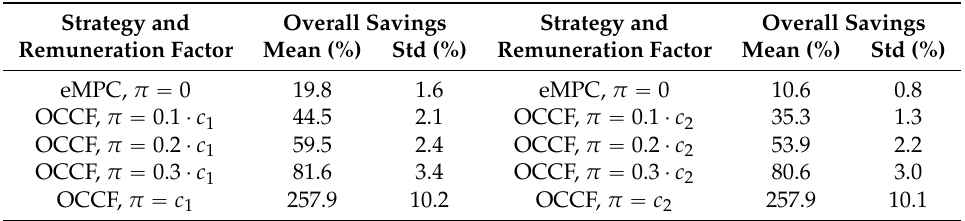
Table 7. Mean value and standard deviation of the overall savings with respect to the MT strategy. Strategy and Overall Savings Strategy and Overall Savings Remuneration